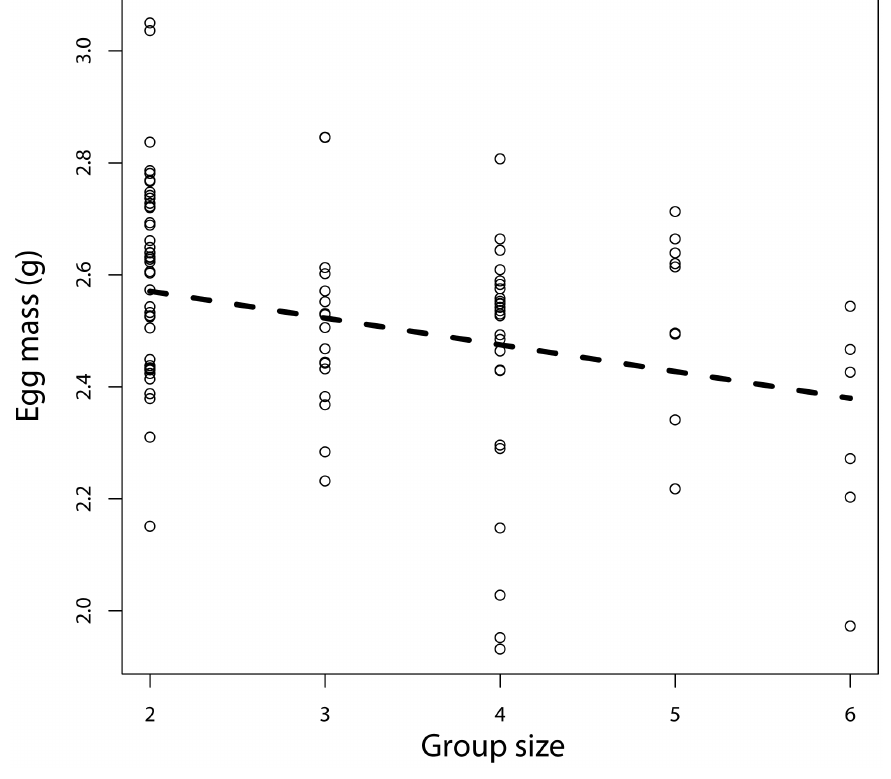
Figure 1. Egg mass decreased in relation to breeding group size. The line indicates the predicted values. doi:10.1371/journal.pone.0059336.g001 PLOS ONE |